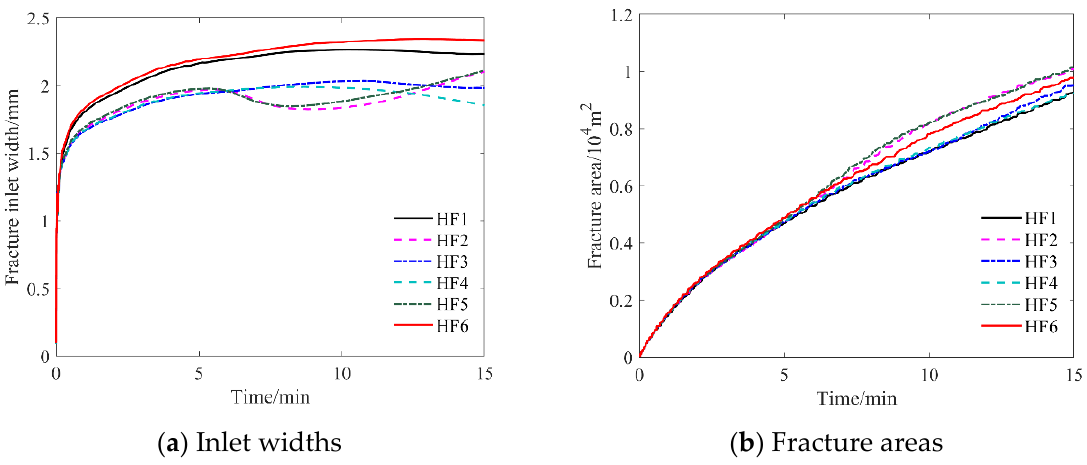
Figure 6. Inlet widths and areas of fractures in the base case group.